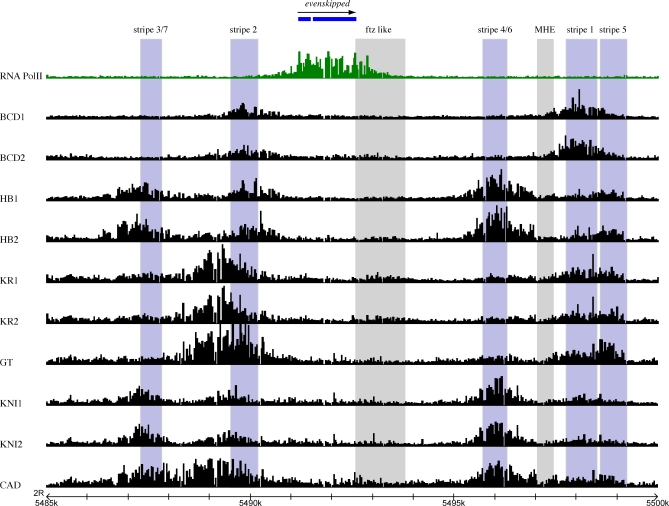
In Vivo Binding to the even skipped LocusOligonucleotide ratio scores for all ChIP/chip experiments across the well-characterized even skipped locus. Data are shown for RNA PolII and all six factors. Note the agreement of the independently purified antibody for BCD, HB, KR, and KNI. The light-blue boxes mark the positions of experimentally characterized A-P enhancers regulating stripe 1 [21], stripe 2 [18], stripes 3 and 7 [101], stripes 4 and 6 [21], and stripe 5 [21]. For comparison, the grey boxes mark the positions of two enhancers that do not respond to these factors in the blastoderm, the ftz-like enhancer [21] and the muscle and heart enhancer (MHE) [102].